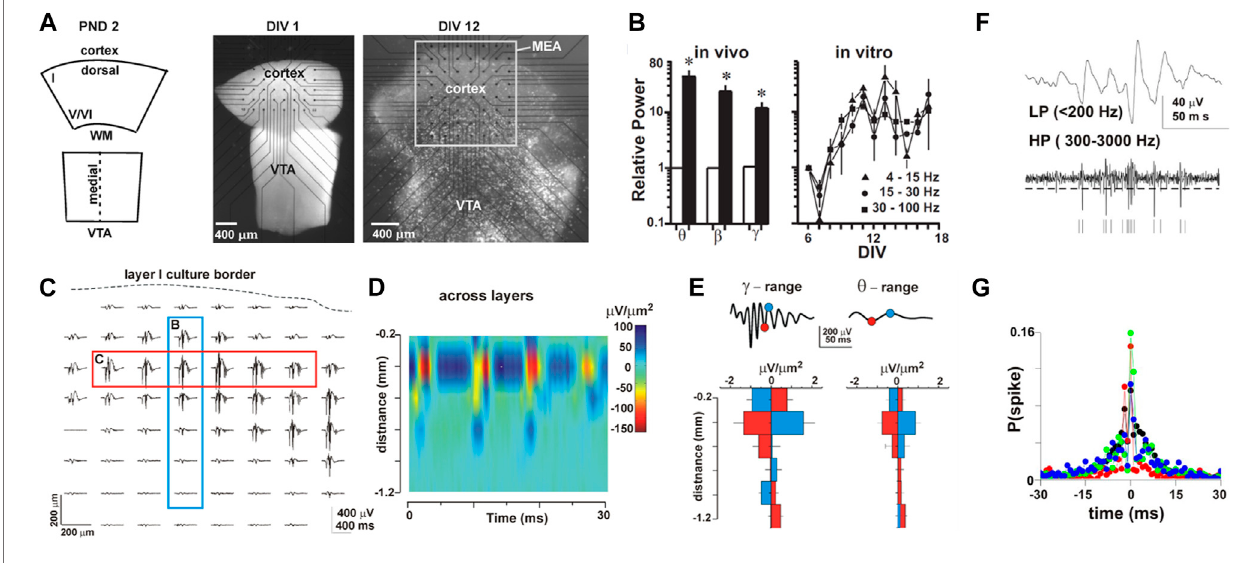
FIGURE 3 | Self-organization into nested θ / γ -oscillations in organotypic cortex cultures during the second week postnatal when super fi cial layers mature. (A) Coronal sections of the cortex and ventral tegmental area ( VTA ) are combined and grown on the MEA over two weeks in culture. Left : sketch of the coronal cortex slice and midlinecrossingmidbrainregioncontainingtheVTAatpostnatal day( PND )1 – 2,whentakenintocultureafter1 day invitro ( DIV1 ; middle ),andabout2 weekslater ( DIV 12; right ). Note fl attening of the culture visible by the increased transparency and expansion of the dorsal tissue on the MEA as super fi cial layers develop (light microscopic image). (B) Nested oscillations increase in power from fi rst ( white ) to second ( black ) postnatal week in vivo ( left ), a developmental time course mirrored in organotypic cortex-VTA cocultures ( right ). (C) Spontaneous nested θ / γ -oscillations distribute along the dorsal part of the cortex within super fi cial layers ( red rectangle ; singleculture). (D) CorrespondingCSD(across bluerectangle inC)demonstrates θ / γ -oscillations tooriginatefromsynapticsources( sinks )withinsuper fi ciallayers;CSD density with distance from the upper culture border over time. (E) Summary of average CSD with distance from the dorsal border for 7 cultures separated into θ - and γ -oscillation activity. (F) Separating the broadband LFP into a spike-information – carrying high-frequency band ( HP ) and the population-activity – containing low- frequency band ( LP ) demonstrates local spiking (vertical bars) to be phase locked to γ -oscillations. (G) Spike probability is highest at the negative peak of the γ -cycle (nLFP) at t (cid:2) 0 (color code shows 4 cultures) (reprinted with permission from [52]; Copyright 2008 National Academy of